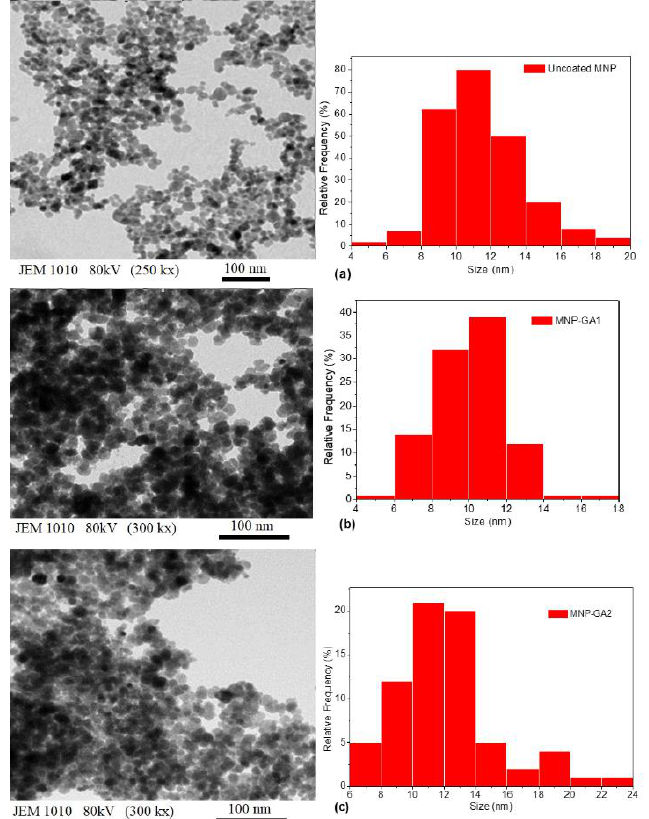
Figure 2. Typical TEM-images (acceleration voltage 80 kV with 250 and 300 kx of magnification) of the magnetic nanoparticles and their size distribution of ( a ) Uncoated MNPs, ( b ) MNP-GA1, and ( c ) MNP-GA2.